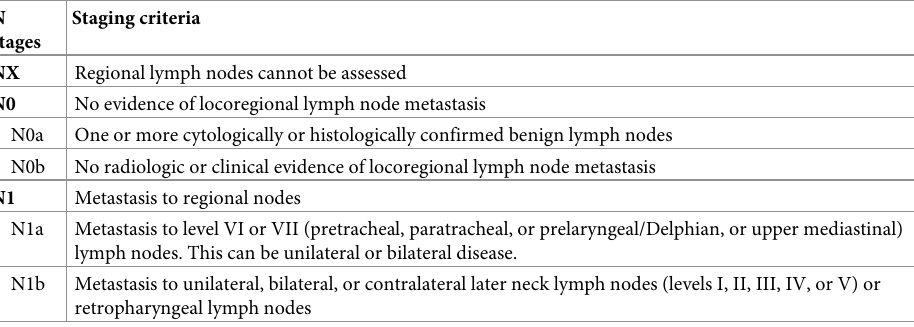
Table 2. Ultrasonic N staging